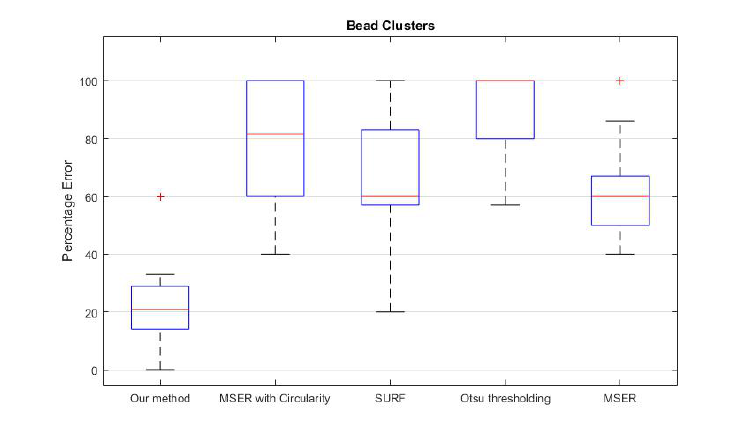
Figure 26. Performance comparison of different perception methods for clustered beads in